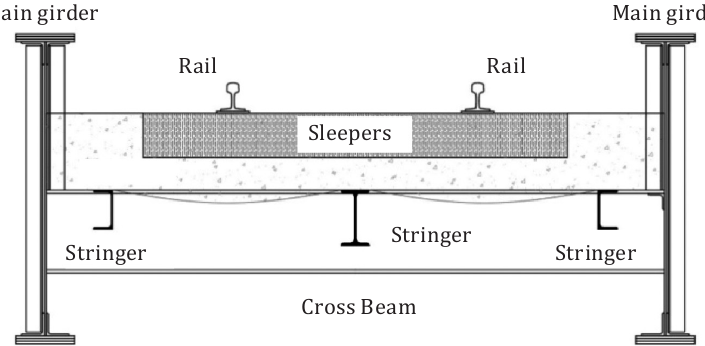
Figure 1. Cross-sectional view of the